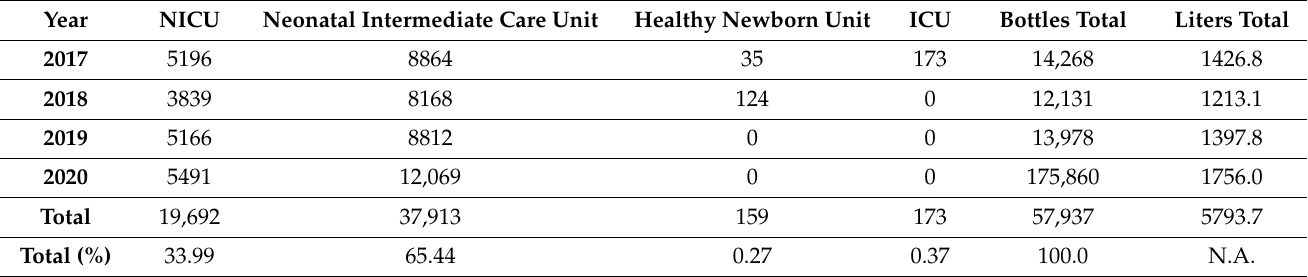
Table 3. PBMin100mLdistributionbottlesdeliveredfromtheHumanMilkBanktoPediatricdepartments.